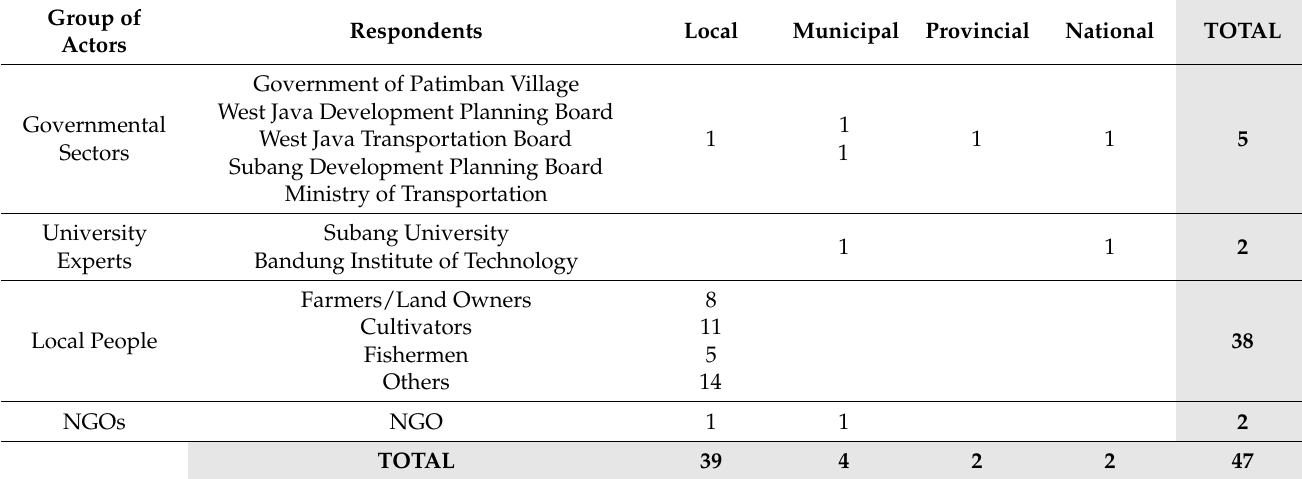
Table 1. Overview of Respondents (own